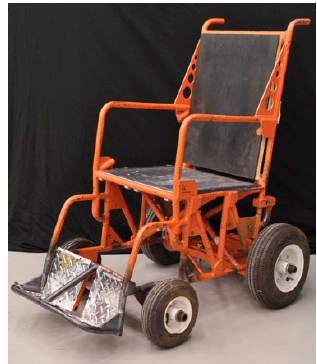
Figure 10. Surrogate wheelchair